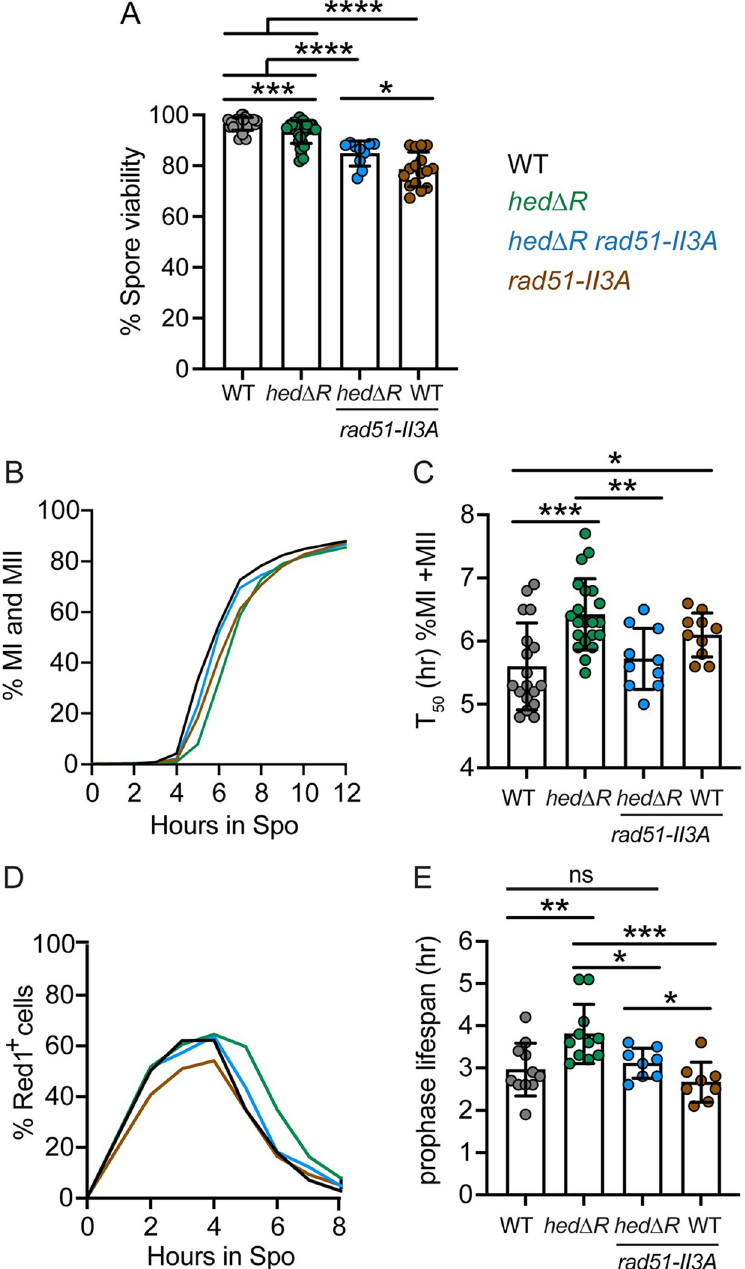
Fig 2. Constitutive activation of Rad51 during meiosis delays prophase I exit. (A) Spore viability. WT (NH716 or NH2598 RCEN), hed Δ R (NH2528 or NH2616 RCEN), hed Δ R rad51-II3A (NH2566) and rad51-II3A (NH2618 or NH2666 RCEN) tetrads from both liquid and solid sporulation conditions were dissected to determine the percent of viable spores. For each replicate, at least 18 tetrads were dissected. (B) Meiotic progression. Timecourses of the WT, hed Δ R , hed Δ R rad51-II3A ( n = 10) and rad51-II3A ( n = 10) were analyzed for meiotic progression as described in Fig 1. The average of all replicates is plotted. (C) Comparison of T 50 values of the individual timecourses shown in Panel B. (D) Prophase I progression. A subset of timecourses in panel A (WT and hed Δ R , n = 11, rad51-II3A and hed Δ R rad51-II3A , n = 8) were analyzed for prophase I progression as described in Fig 1. The average of all replicates is plotted. (E) Prophase I lifespan for each sporulation culture in Panel D was calculated as described in Fig 1. The data for WT and hed Δ R used for Panels B and D are the same as shown in Fig 1. The statistical significance of differences between strains in Panel A was determined using the Mann-Whitney test, while Panels C and E used an unpaired, two- tailed Student’s T-test. ( � = p < .05; �� = p < .01; ��� = p < .001, ���� = p < .0001).